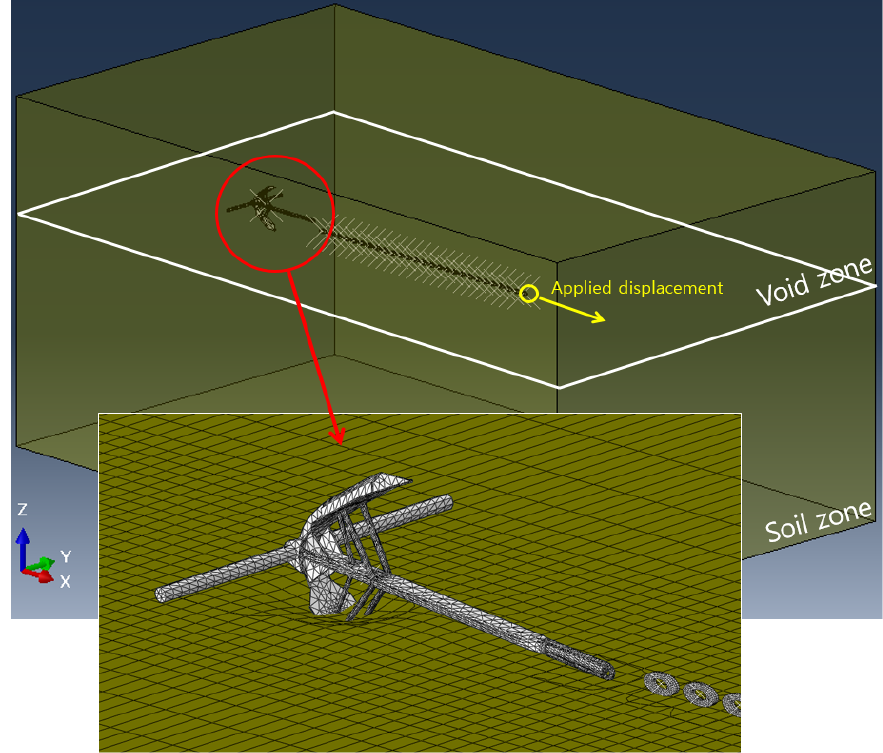
Figure 10. Large deformation finite element (LDFE) modeling using the CEL method. The boundary condition of the soil was imposed to constrain the displacements of both the bottom and side parts. In addition, the soil was modeled inside the initial Eulerian domain to impart physical properties. The boundary conditions were applied to each surface, together with the geostatic stress conditions. Geostatic stress was used to help create an initial soil more similar to the actual soil and was applied up to the final step.